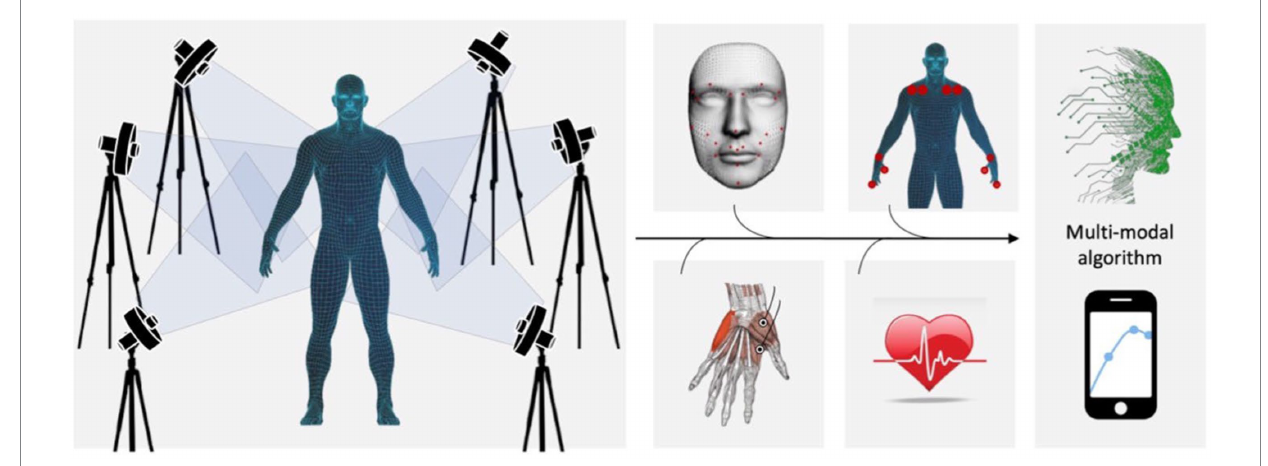
FIGURE 2 We propose an integrated methodology (i.e., kinematical 3-D analysis of movement, pupil dilation, gaze, EMG, heart rate variability, self-reports, and machine learning) to extract multi-modal detection algorithms able to discriminate the specific patterns of a wide range of blended emotion displays even in ecological contexts (e.g., with smartphone